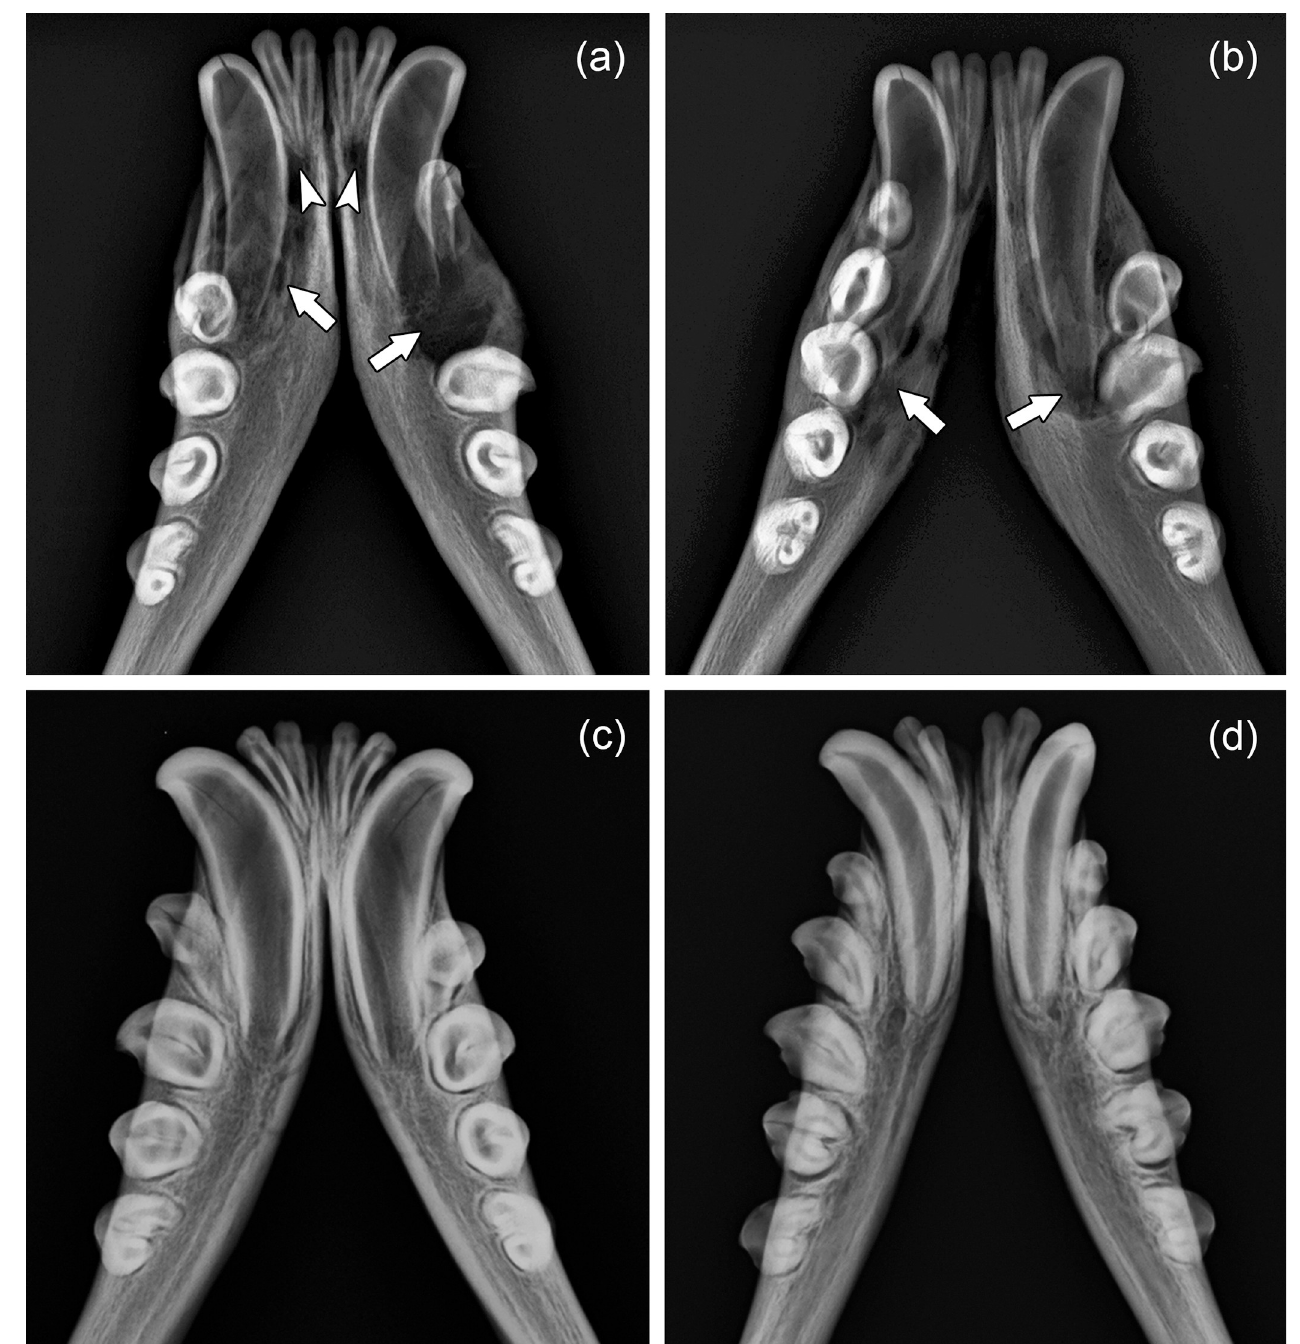
Fig 4. Radiographs (dorsoventral projections) of the anterior portions of the mandibles of four juvenile Baltic grey seals ( Halichoerus grypus grypus ). Note thin walls of the mandibular C exhibiting exposed pulp cavities through openings at the crown tips in the two specimens shown in (a) [ZMUC 42 4 ] and (b) [ZMUC 303] compared to thicker canine walls in the unaffected “control” specimens shown in (c) [ZMUC 71 3 ] and (d) [ZMUC CN 1157]. Arrows: radiolucent areas around the roots of the canines, indicative of pronounced periapical osteolysis. Arrowheads: radiolucency around the root apices of